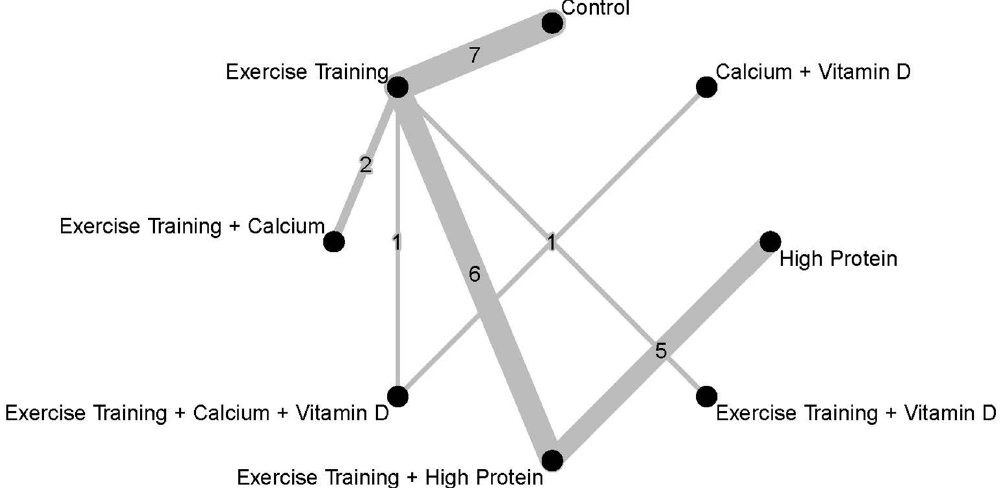
Figure 5. Network geometry and number of studies in each comparison. Every intervention was compared to a Control. Weighted effect sizes are presented as SMDs and their corresponding 95%CI.